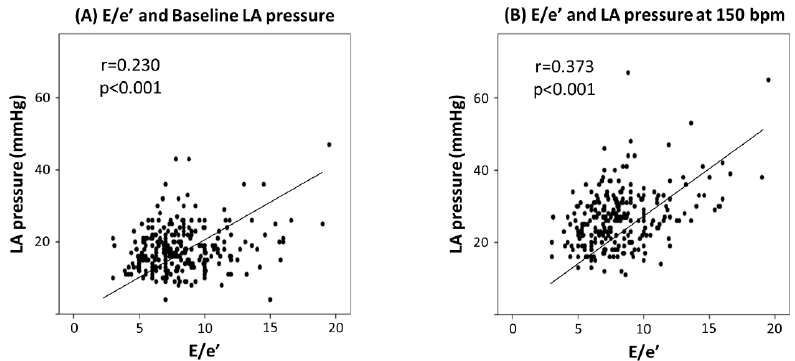
Figure 2. The pattern of heart rate dependent LA pressure response. ( A ) In AF and control groups, LA pressure response as heart rate change showed a similar pattern. ( B ) The different LA pressure response between both low and high E/e’ group. AF, atrial fibrillation; LA, left atrial.